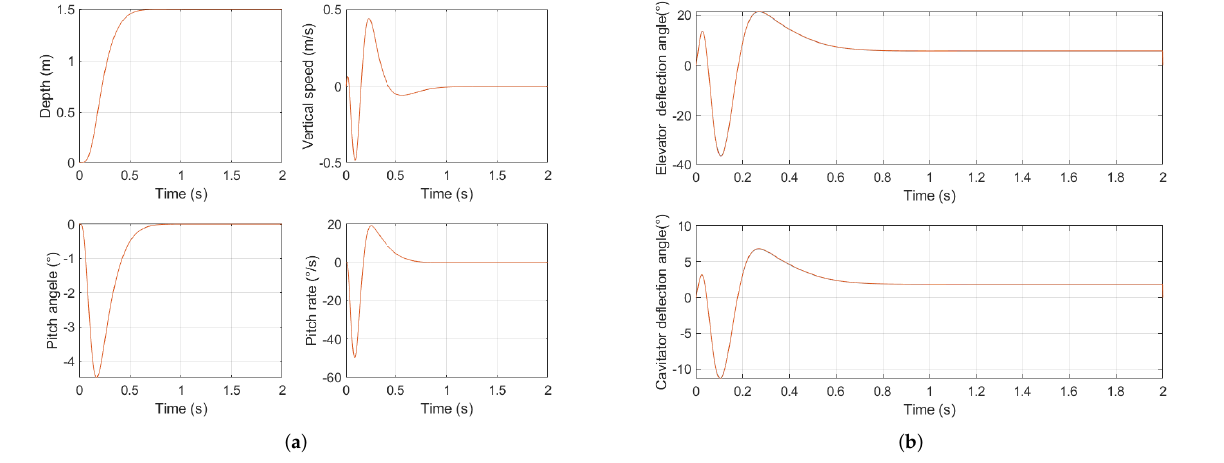
Figure 12. Monte Carlo simulation with perturbation of σ : ( a ) Four states with perturbation of σ ; ( b ) Actuator with perturbation of σ .